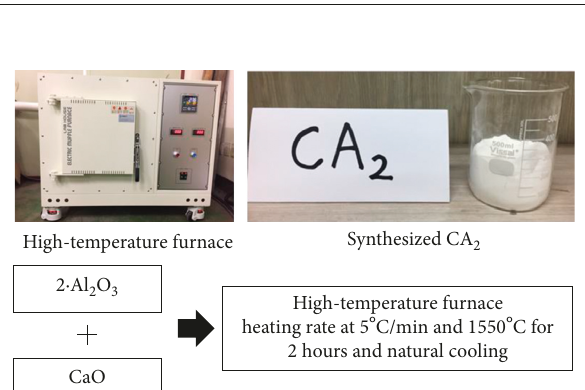
Figure 2: Process of CA